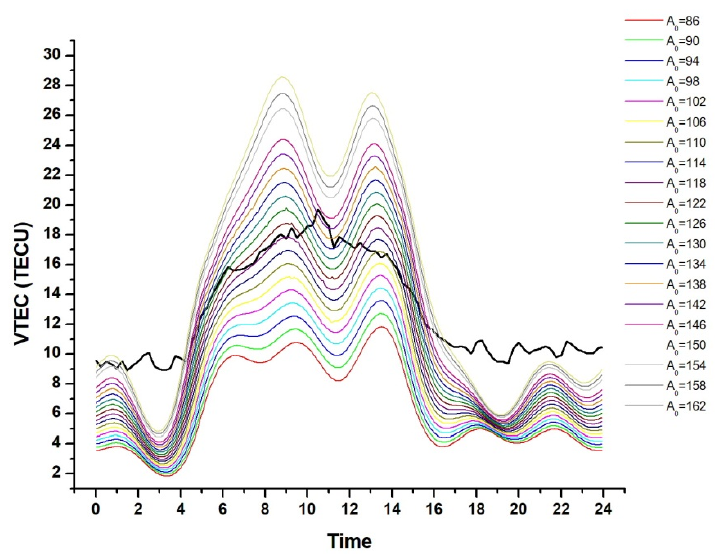
Figure 7. Actual VTEC profile over Cyprus (thick black line) and NeQuick-G VTEC profiles for different A 0 values.